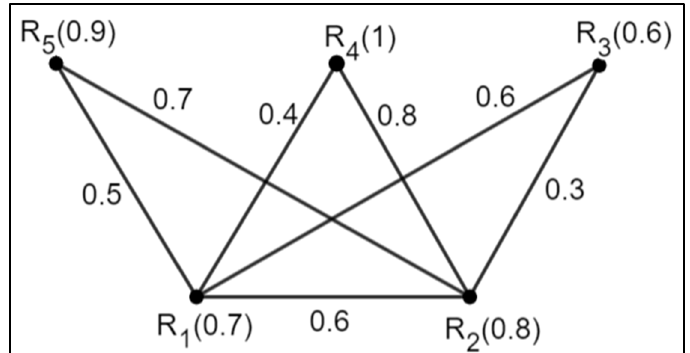
Figure 1. Book Graph.